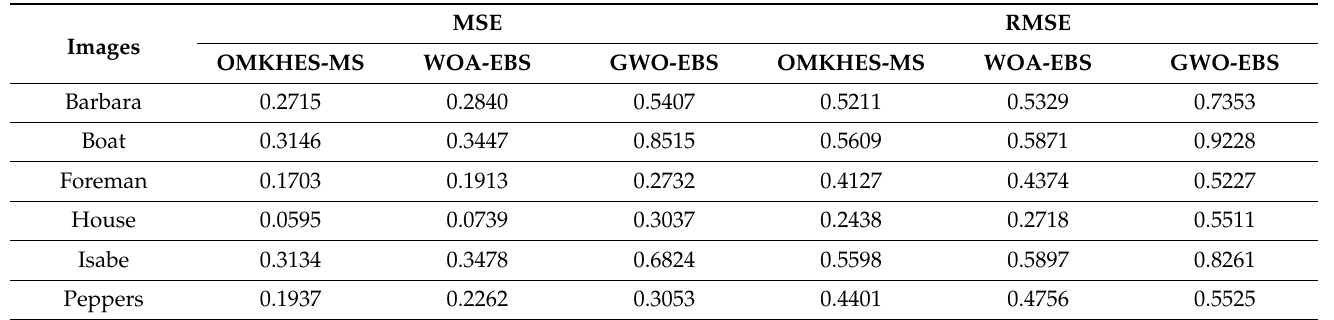
Table 1. MSE and RMSE analysis of OMKHES-MS technique with different images.